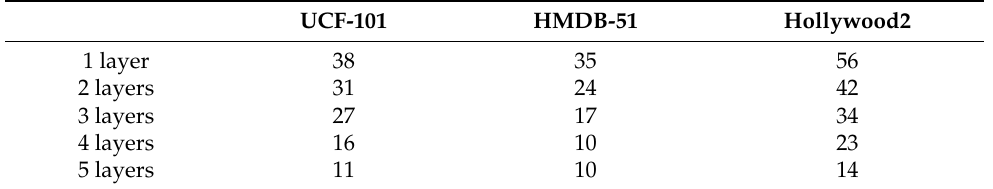
Table 3. The training speed comparison of stacked ST-D LSTM units with different layers (in frames per second).